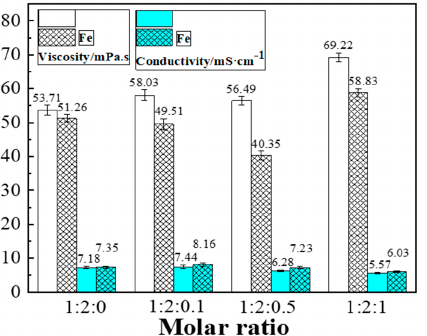
Figure 2. Conductivity and viscosity of the DESs at 25 °C without and with FeCl 3 ·6H 2 O.